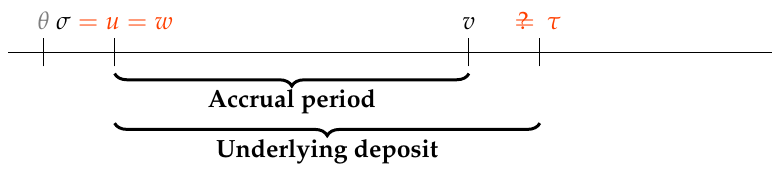
Figure 2. Representation of the dates associated to a LIBOR fixing and a FRA